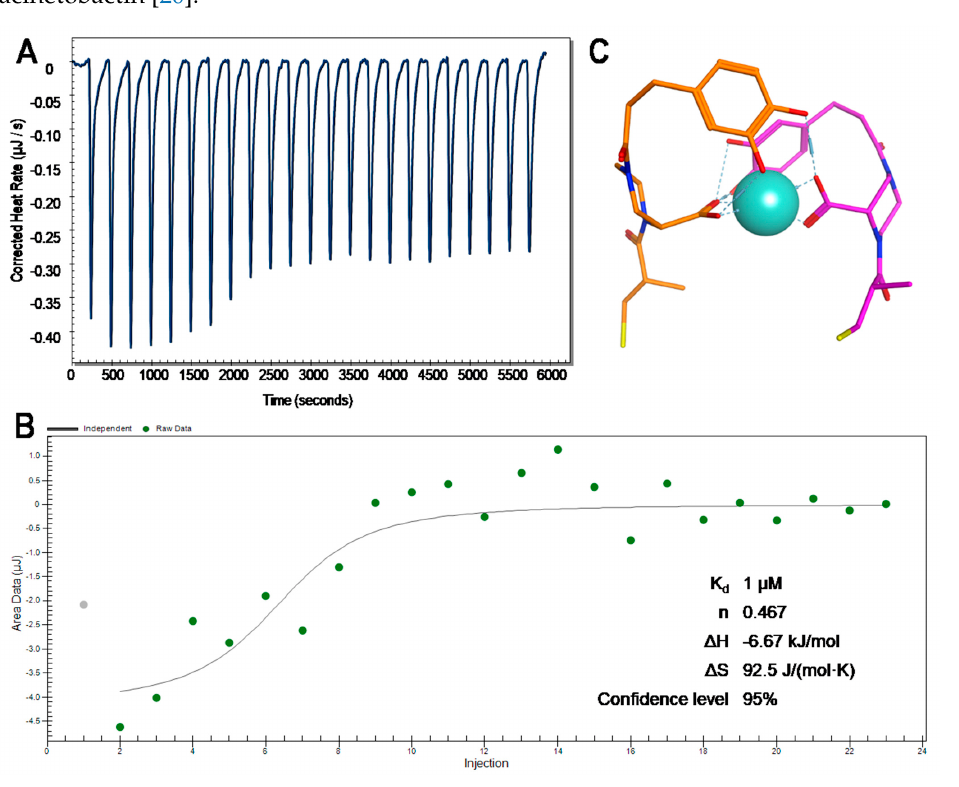
Figure 4. Binding of compound 3 to Fe 3+ . ( A ). ITC measurement of the binding event. FeCl 3 solution was titrated to the solution of compound 3 . ( B ). Model fit of the 3 :Fe 3+ binding. ( C ). Model structure of two molecules of 3 (orange and purple sticks) binding to Fe 3+ ion (cyan sphere).